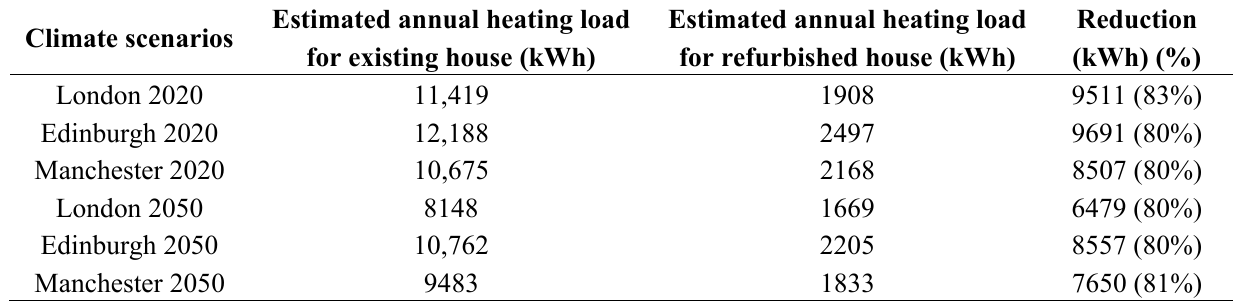
Table 9. Annual energy savings for future climate